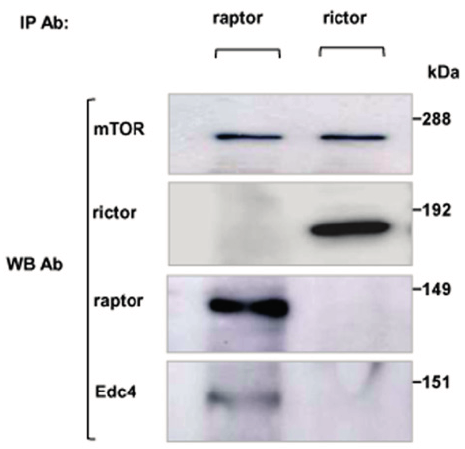
Figure 2. Edc4 interaction with mTORC1, but not with mTORC2: CCRF-CEM cells were lysed and endogenous mTOR complexes were immunopurified using raptor and rictor antibodies, respectively. The IP elutes were resolved on SDS-PAGE and immunoblotted with indicated antibodies which confirmed that Edc4 was only associated with mTORC1 but not with